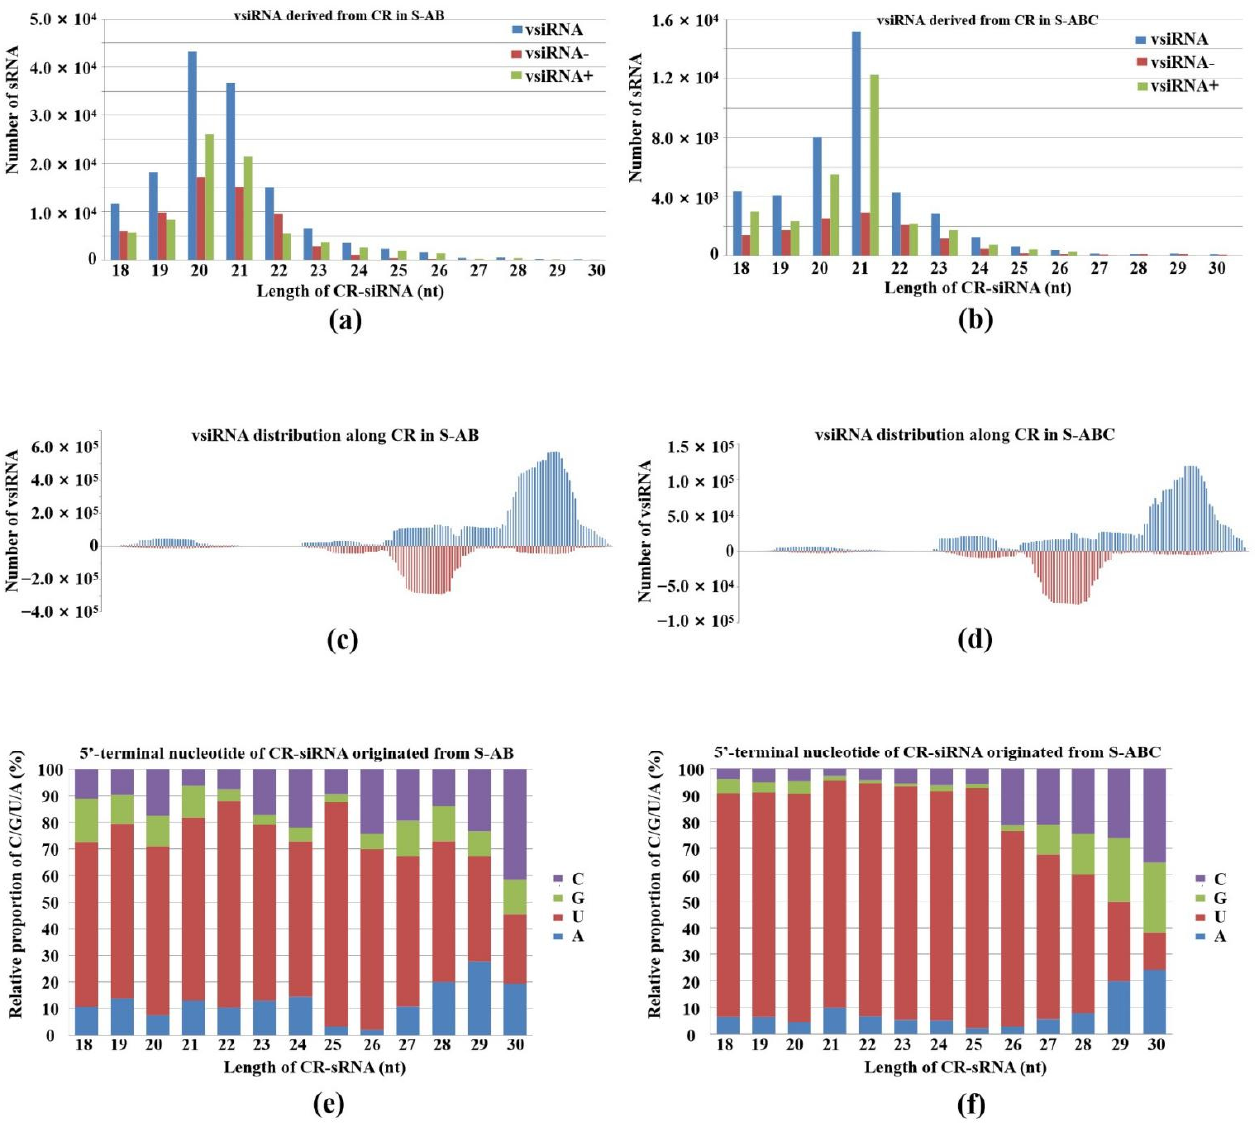
Figure 6. Characterization of vsiRNA derived from the CR sequence of FgGMTV1. ( a,b ) Size distri- bution, ( c,d ) genome mapping and ( e,f ) 5 ′ -terminal nucleotide of CR-siRNAs originating from S-AB and S-ABC libraries, respectively. S-AB (S-S strain infected with DNA-A and DNA-B segments of FgGMTV1), S-ABC (S-S strain infected with DNA-A, DNA-B and DNA-C segments of FgGMTV1). In animals and plants, different DCLs are responsible for different sized sRNA cleav- ages. There are four DCLs (DCL 1, 2, 3 and 4) in F. graminearum [42], but their cleavage sRNA sizes remain unexplored. The 22-nt sRNA was the peak for virus-free F. gramin- earum . However, the 30-nt class of sRNAs, followed by the 21-nt class, accounted for the highest proportion in the FgGMTV1-infected library, S-ABC. Unlike the S-ABC library,